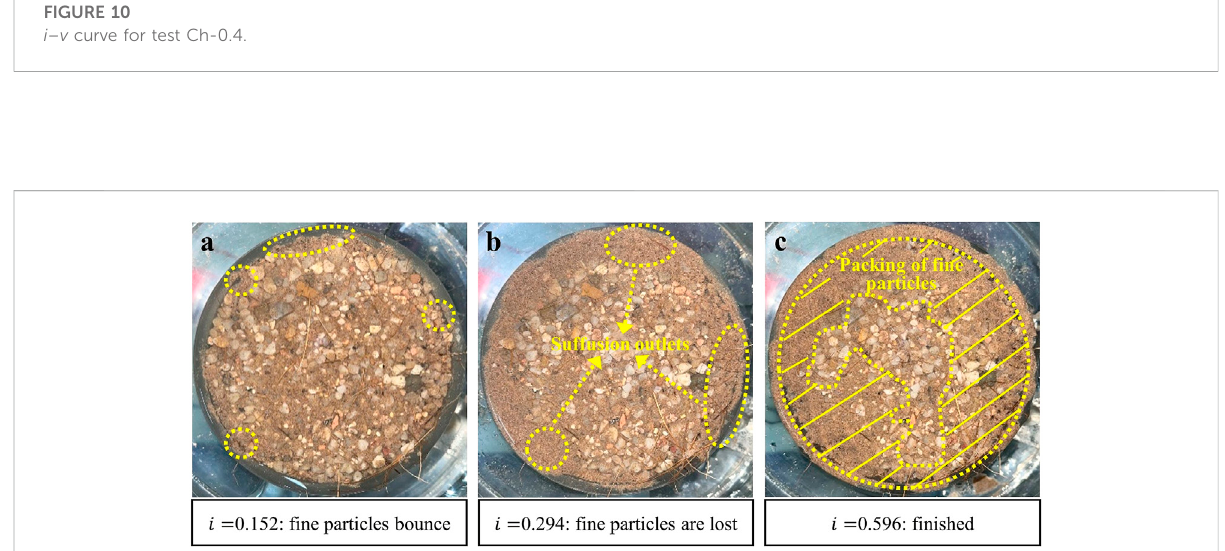
Frontiers in Earth